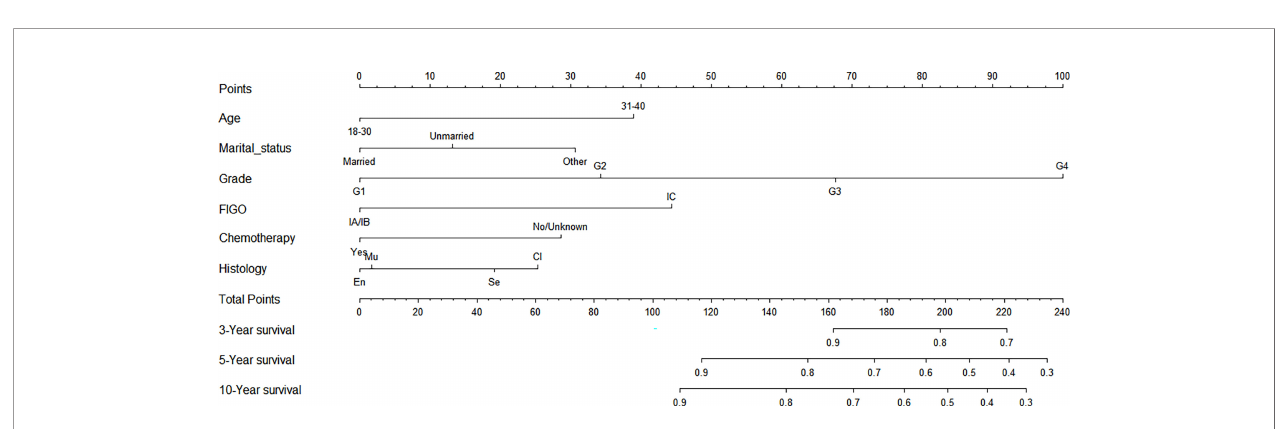
FIGURE 4 | Nomograms to predict 3-, 5-, and 10-year CSS for stage I